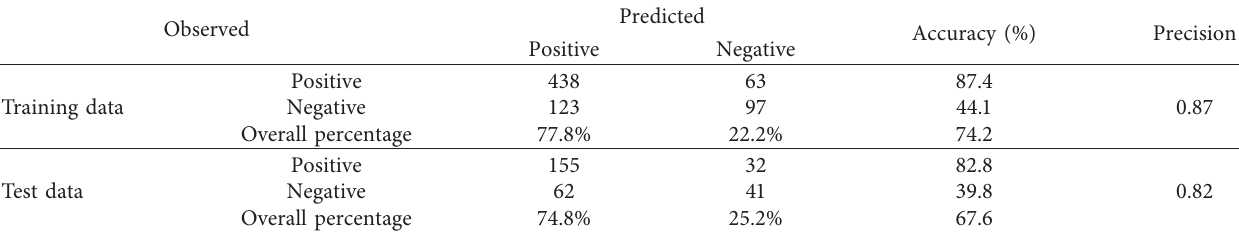
Table 12: Confusion matrix, accuracy, and precision of the informative sign